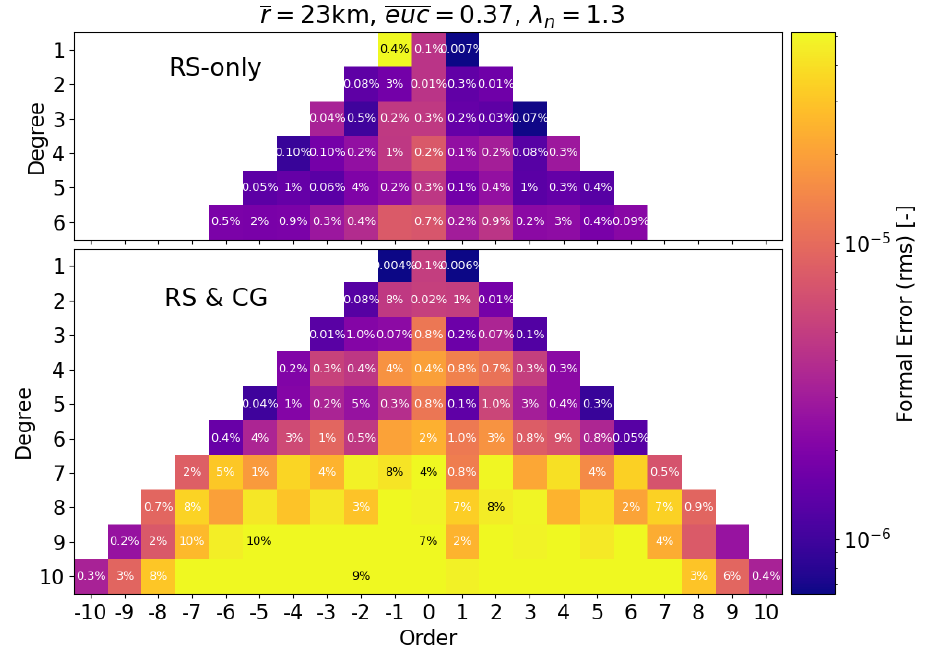
Figure 6. Formal errors for the gravity spectrum obtained via the best orbit in the RS experiment, marked by a star in Figure 5. This leads to the highest accuracy for degrees 1 to 3, and entails low maintenance costs. Errors are reported as absolute (colour) and homogeneous-normalised (percentage) values. Missing percentages indicate a formal error greater than 100%, some of which correspond to harmonics with very small magnitudes in the homogeneous model (mainly at degrees 7 and 9). Note that the true errors for the top pyramid could increase by a factor of 4–6 due to the influence of systematic uncertainties (see Figure 11) and a reduction in tracking